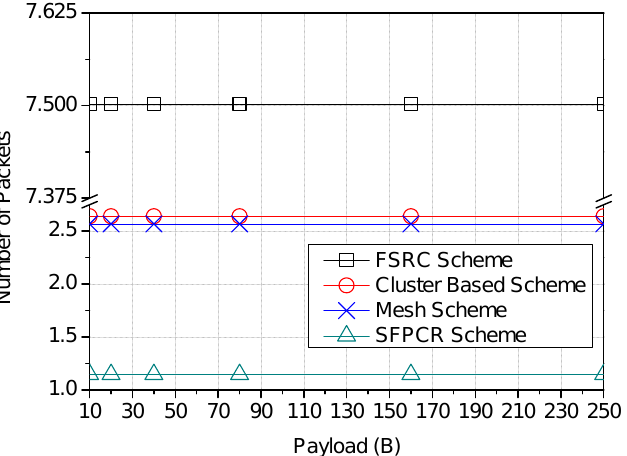
Figure 12. Variation in the number of packets according to the payload size (B) with a comparison between the proposed SFPCR scheme and other